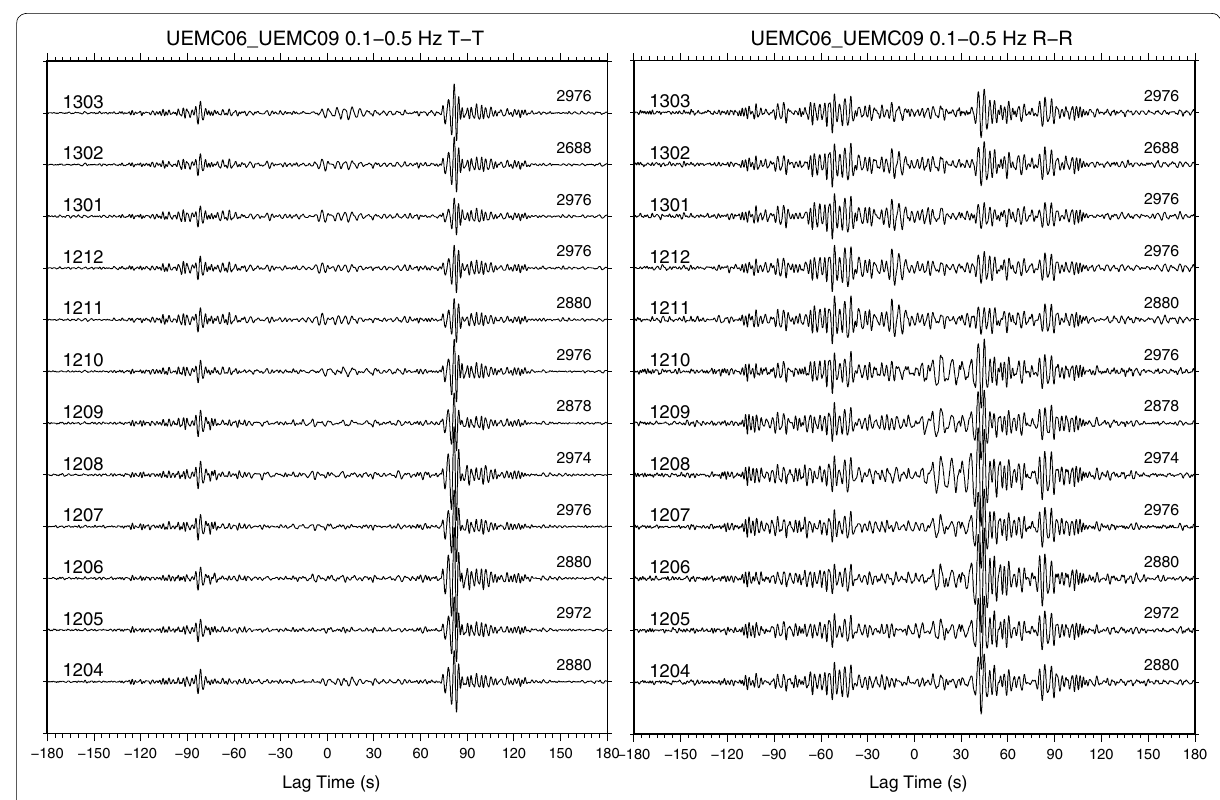
Fig. 3 Monthly stacked inter-station cross-correlation functions for transverse–transverse ( T – T ) components ( left ) and radial–radial ( R – R ) compo- nents ( right ) in the frequency range 0.1–0.5 Hz for station pair UEMC06–UEMC09. The four-digit number on the left of a trace indicates the month and year corresponding to the trace (e.g., 1303 means March 2013). The number on the right of a trace represents the number of time segments stacked to produce the stacked cross-correlation